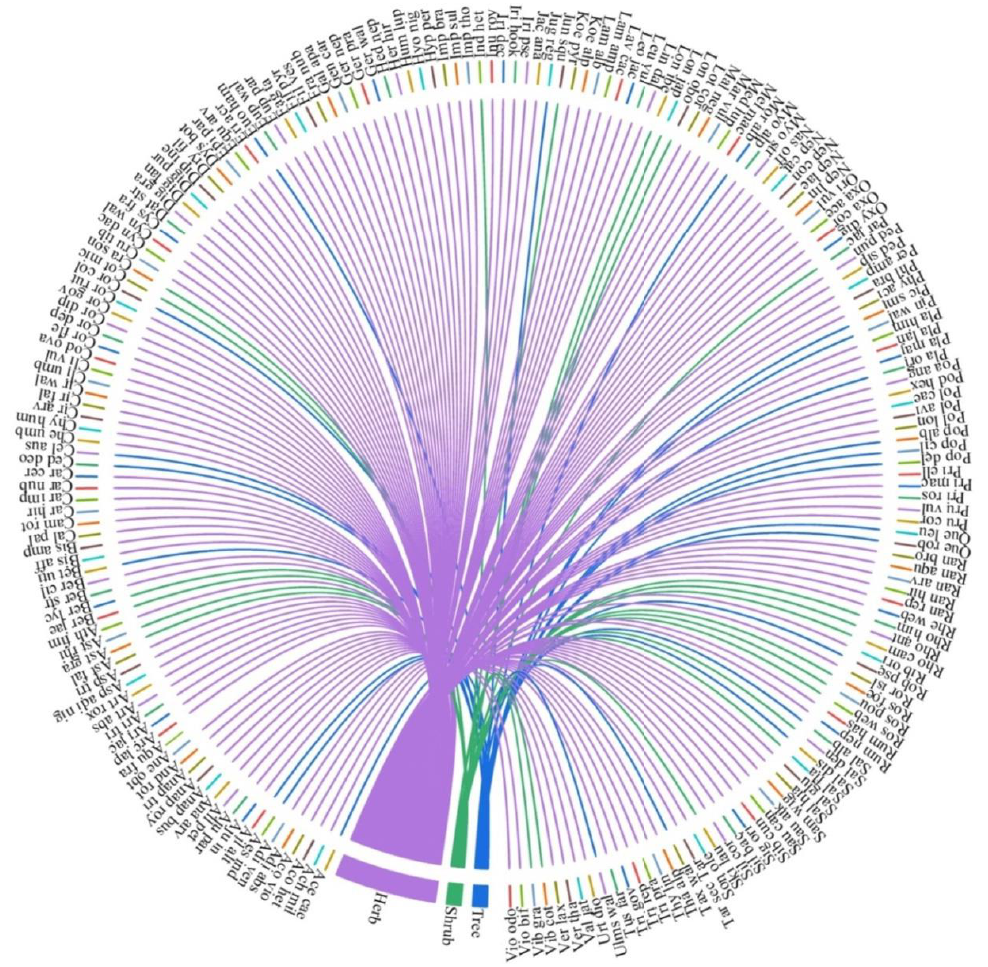
Figure 2. Growth form of the documented plant